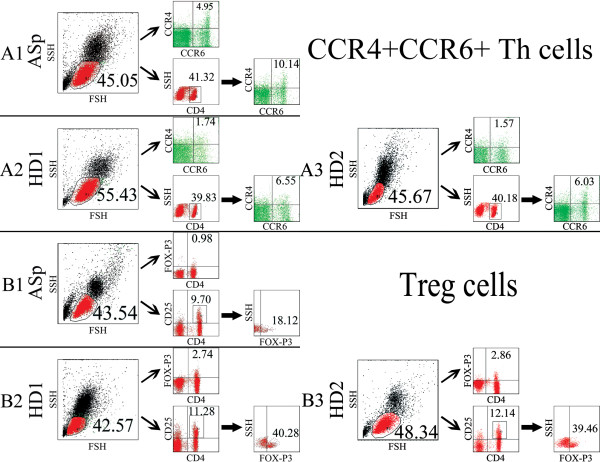
Representative plots of CCR4+CCR6+ T-helper and regulatory T cells. Representative plots of peripheral circulating populations of (A1) to (A3) CCR4+CCR6+ T-helper (Th) cells (green) and (B1) to (B3) regulatory T (Treg) cells (red) in peripheral blood mononuclear cells (PBMCs) of patients with ankylosing spondylitis (ASp) (A1, B1), HLA-B27-negative healthy donors (HD1) (A2, B2) and HLA-B27-positive healthy donors (HD2) (A3, B3). FOX-P3, forkhead box P3; FSH, forward scatter-height; SSH, side scatter-height.